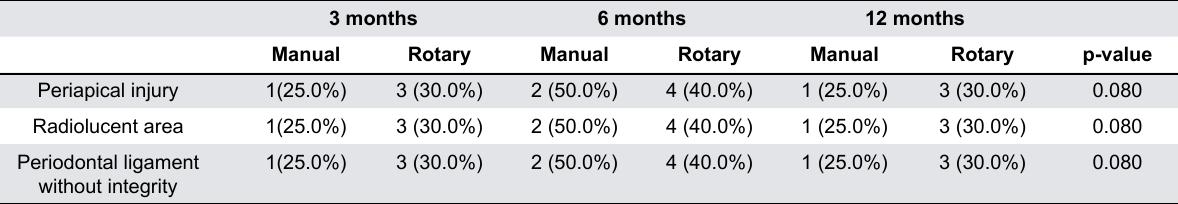
Table 7- Correlational analysis between restoration retention and the occurrence of periapical